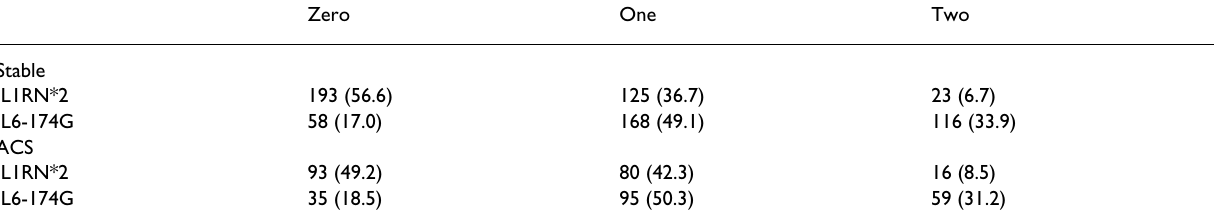
Table 4: OPUS TIMI-16 study: WBC Median (Q1, Q3) Gene Zero One Two